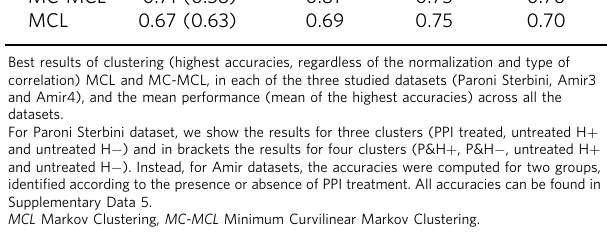
Table 2 Ranked performance of unsupervised dimension reduction techniques on the real datasets.